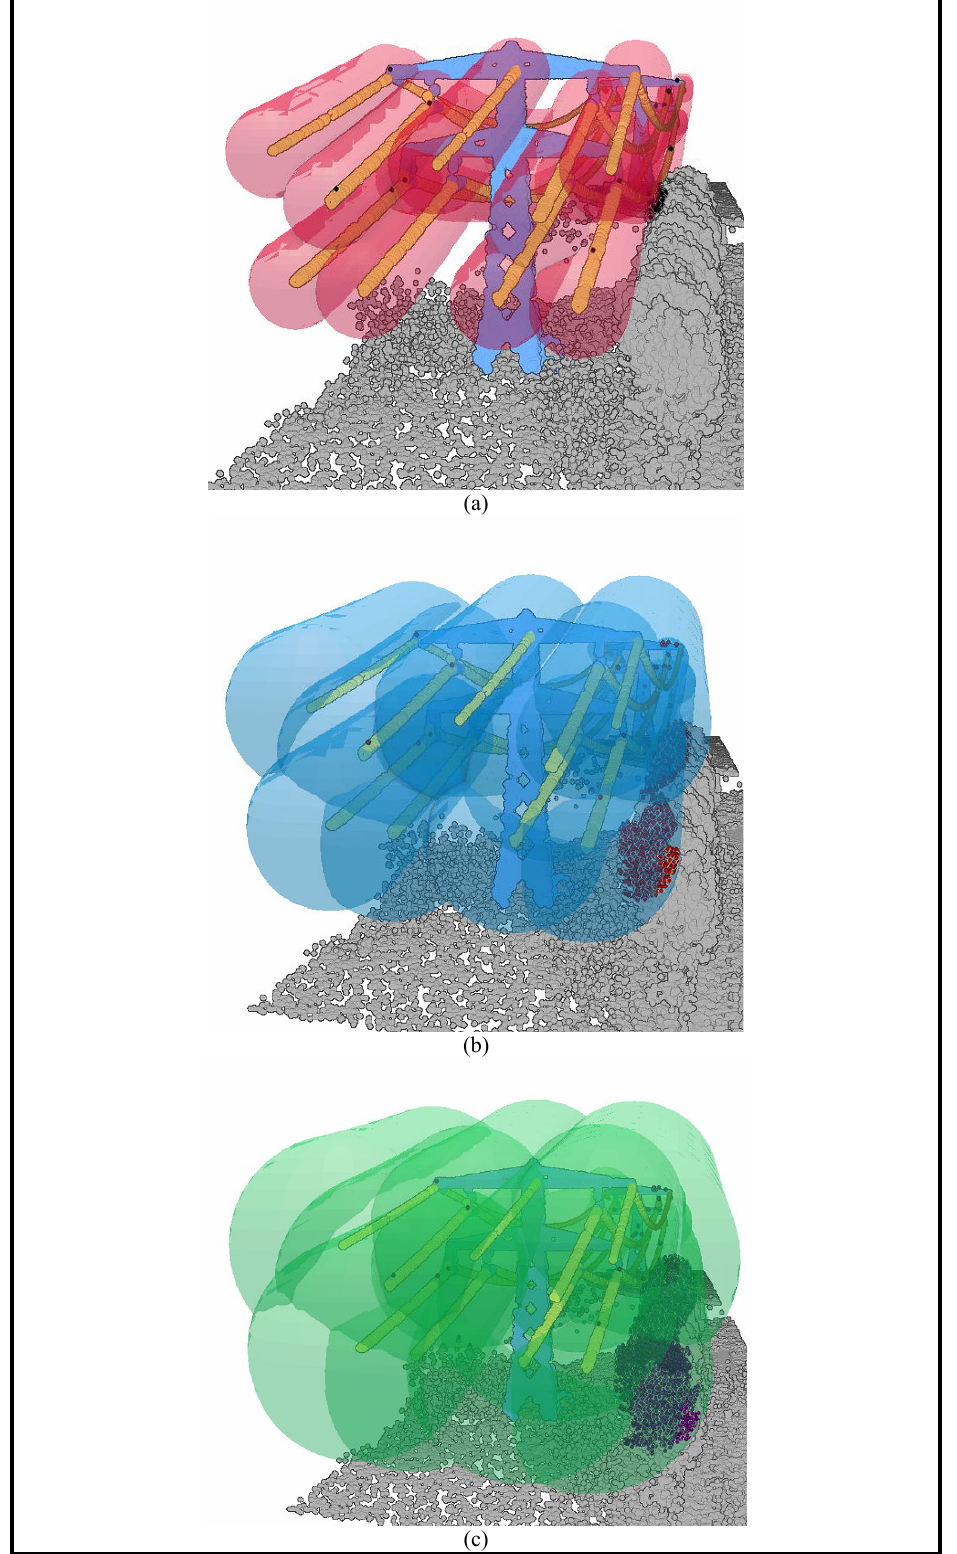
Figure 6. Visualization of obstacles within a 5m, 10m, and 15m